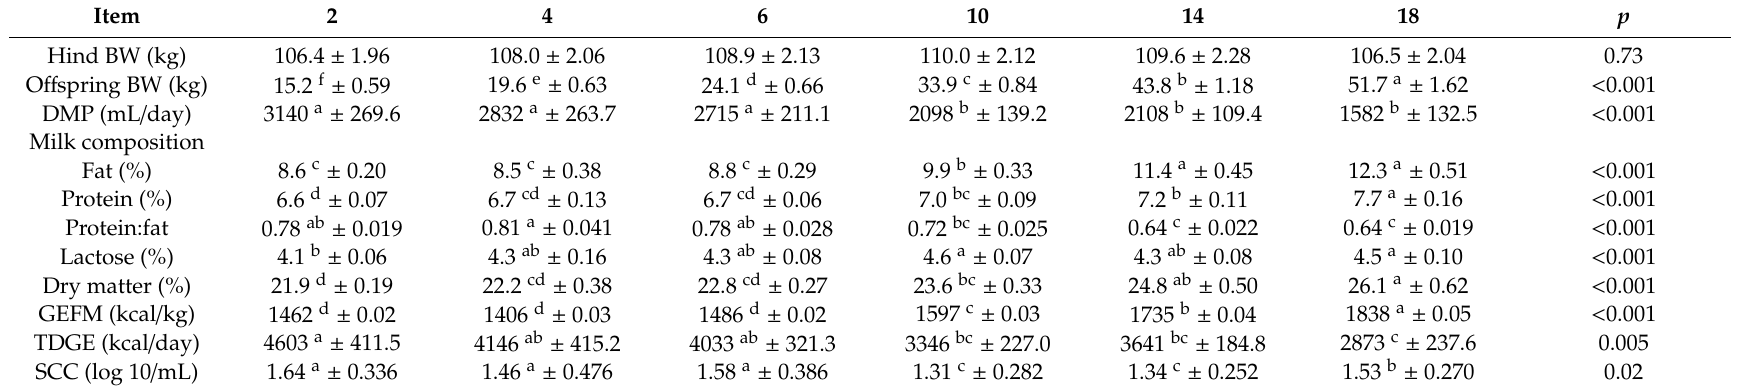
Table 3. E ff ects of lactation week on body weight (BW) of hind and o ff spring, daily milk production (DMP), milk composition, gross energy content of fresh milk (GEFM), total daily gross energy content (TDGE), and somatic cell count (SCC) of Iberian red deer hinds fed a balanced diet. Data are means ± standard error of mean 1